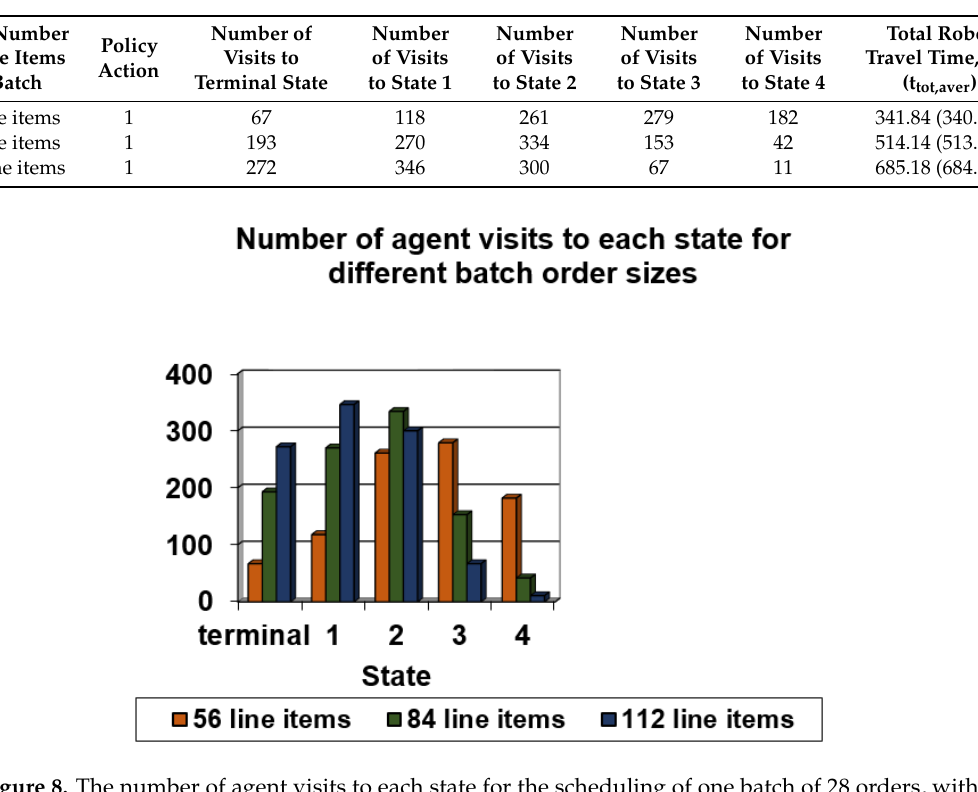
Figure 8. The number of agent visits to each state for the scheduling of one batch of 28 orders, with mean order size (i) two line items per order; (ii) three line items per order; and (ii) four line items per order.